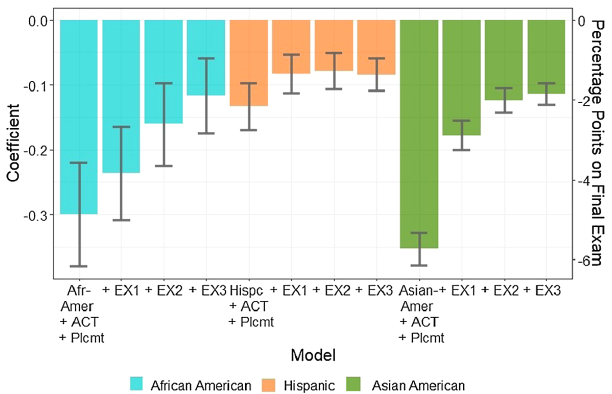
FIG. 4. Multiple linear regression coefficients from the exam models reported in Table VII with the coefficient from model 6 of Table V included for comparison. Model 6 is represented by the leftmost bar for each racial or ethnic group, and models 7 – 9 follow consecutively. Coefficients represent the standardized difference in final exam performance between non-Hispanic White American students and the specified group. The error bars represent the standard error for each coefficient. All coefficients are statistically significant with p < 0 . 05